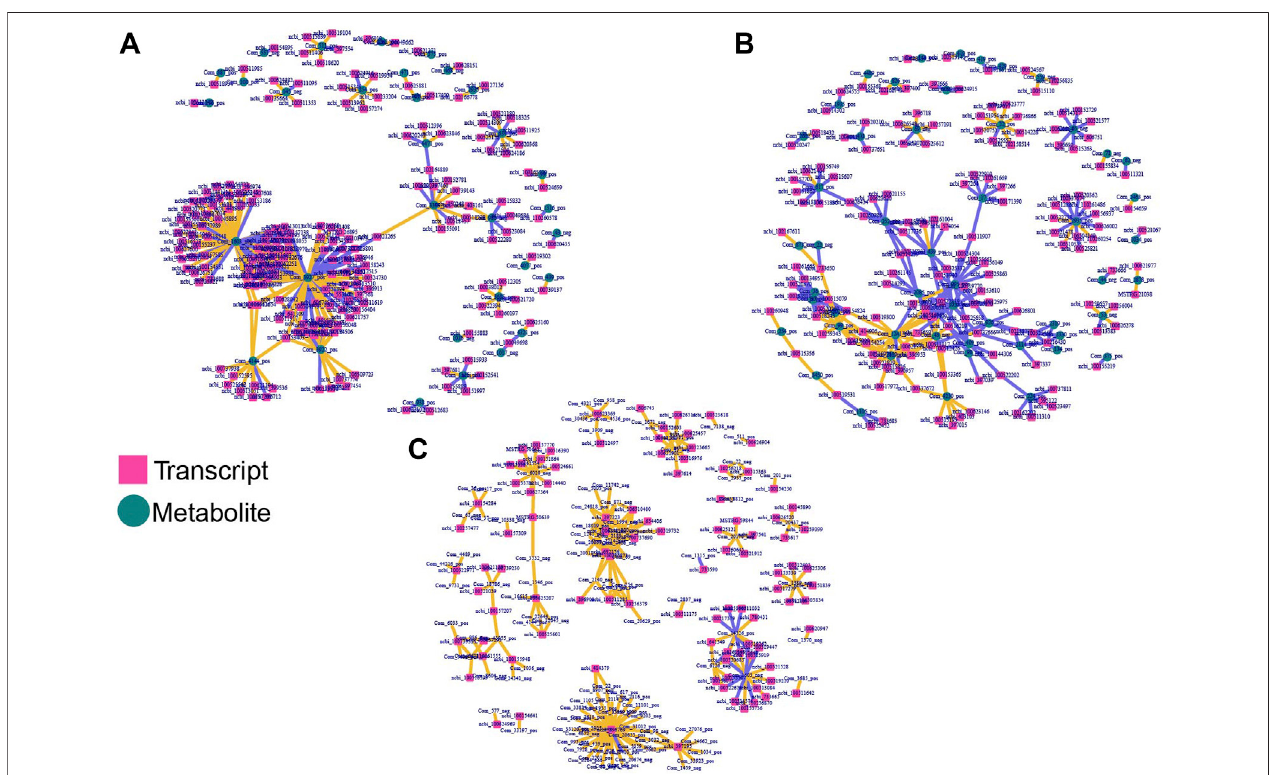
FIGURE 6 | Integrated network analyses of DEGs and DAMs. The square nodes represent transcripts, and the circle nodes represent metabolites. (A) Co- expression network analyses of DEGs shared for normoxic (TN and LN) and hypoxic (TL and LL) groups and DAMs. (B) Co-expression network analyses of speci fi c DEGs (excluding DEGs shared between normoxia and hypoxia groups) and DAMs for TN and TL groups. (C) Co-expression network analyses of speci fi c DEGs (excluding DEGs shared between normoxia and hypoxia groups) and DAMs for TN and TL groups.